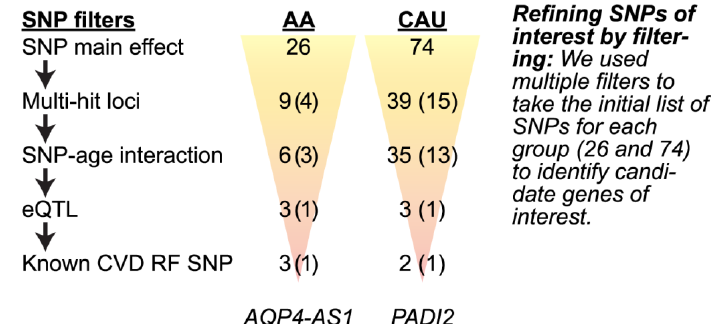
Figure 5. Workflow to identify genetic regions of interest that associate with Δ SBP. We used a series of data filters (SNP filters) to refine potential loci associated with the responsiveness to our HTN intervention. The number of individual SNPs associated with ΔSBP within each ancestral group is indicated (SNP main effect) and the remaining number of SNPs after each filter ( ↓ ) as well as the corresponding number of loci represented by the SNPs are provided in parentheses: #SNPs (#loci). eQTL: expression quantitative trait loci; CVD RF: cardiovascular disease risk factor; AQP4-AS1 : Aquaporin 4 antisense RNA 1; PADI2 : protein-arginine deiminase type II.